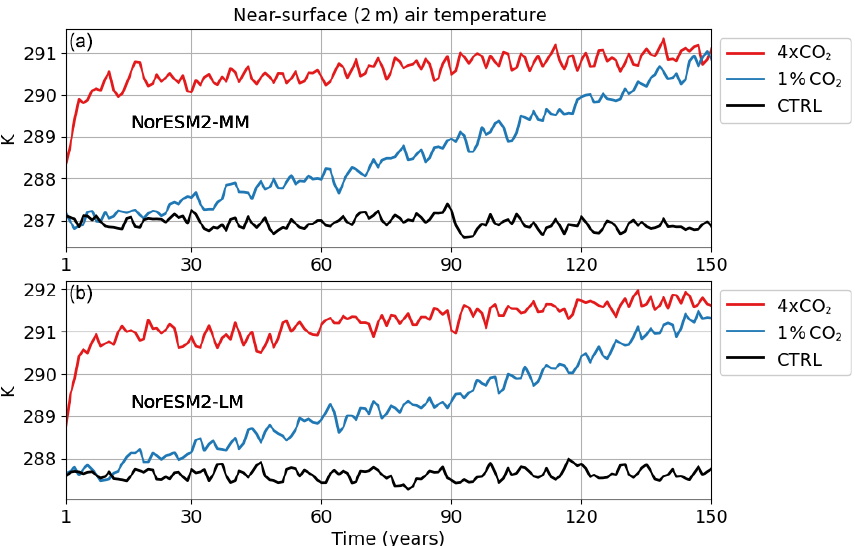
Figure 3. Time evolution of globally averaged near-surface temperature in NorESM2-MM (a) and NorESM2-LM (b) for the pre-industrial control simulation, the abrupt-4xCO2 experiment, and the gradual increase 1pctCO2 experiment for model years